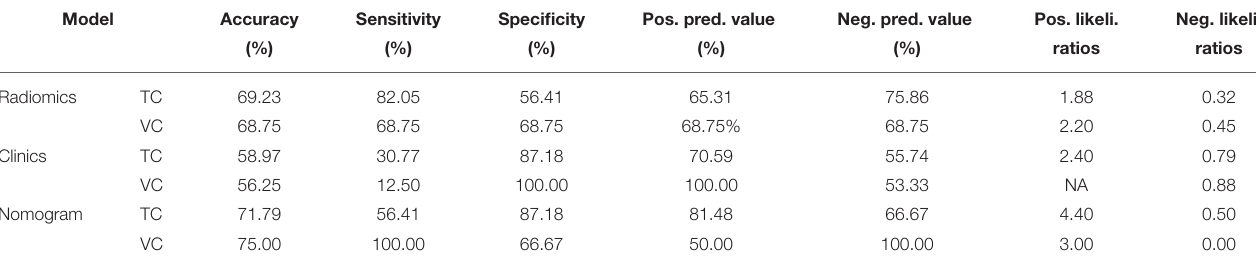
TABLE 2 | Parameters of the three models.